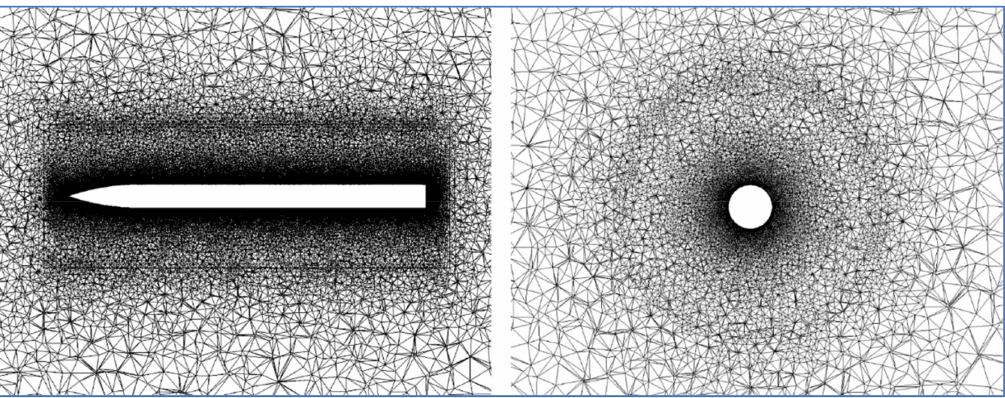
Figure 7. Grid U1. ( Left ) detail of the nearfield at plane x-z. ( Right ) detail of the nearfield at plane